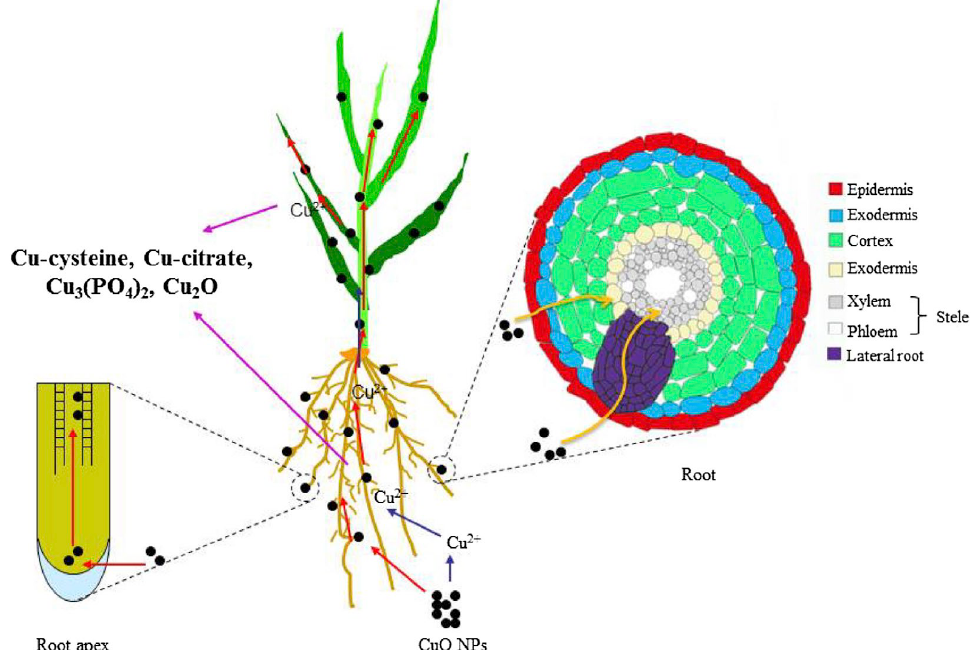
Figure 4. Nano-Fe 3 O 4 -modified biochar promotes Fe film formation and Cd fixation in rice roots. Reprinted with permission from Ref. [12]. 2015,